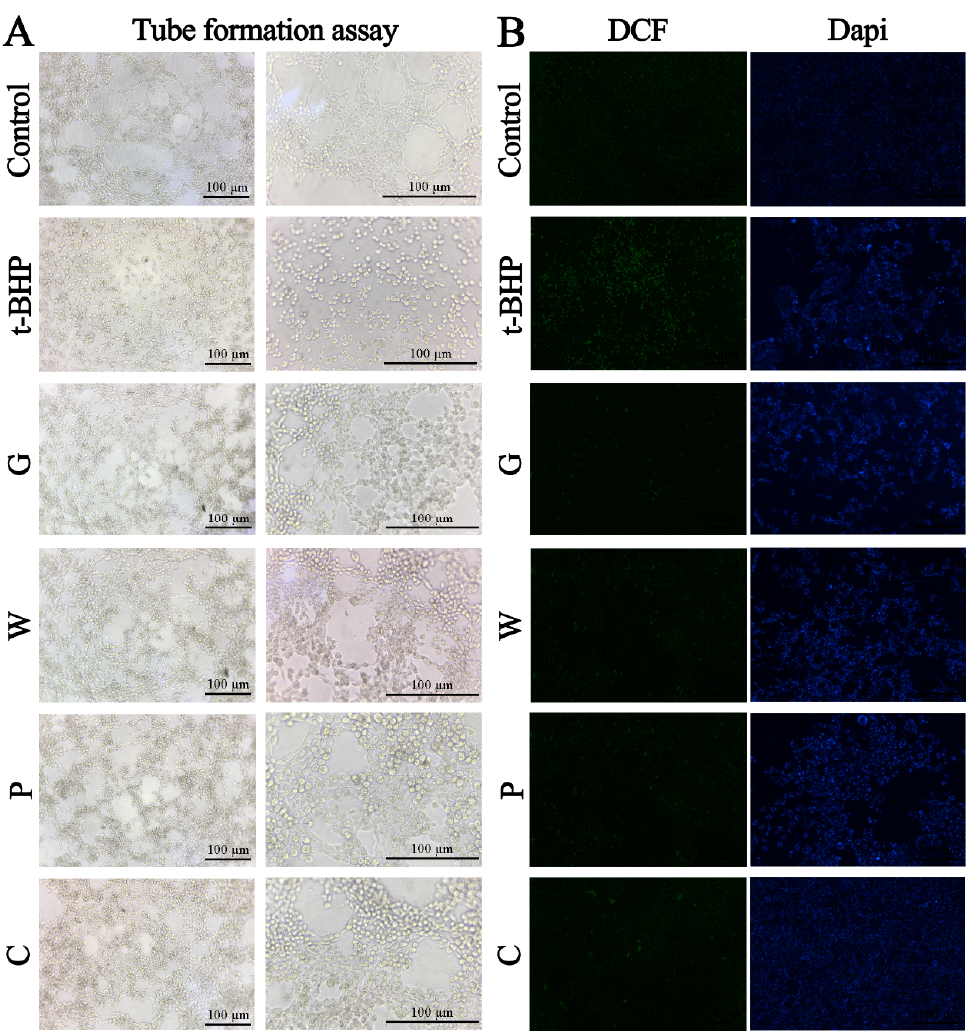
Figure 5. Efficacy evaluation of the crude and the processed Curcuma zedoaria on ROS related oxidative damage by HBMEC assays. ( A ) Angiogenesis of HBMECs under the microscope (100× and 200×). The most representative fields are shown. ( B ) Morphological observation of HBMECs induced by 40 μM t-BHP and/or the crude and the processed Curcuma zedoaria (83.33 mg/mL) by ROS and 4',6-diamidino-2-phenylindole (DAPI) assay under the fluorescence microscope (50× and 100×). The most representative fields are shown. DCF, compounds with fluorescence for the reflection of ROS levels. Dapi, morphological observation using DAPI Staining. Con, control group treated with PBS; Mod, model group treated with 40 μM t-BHP; Pos, positive control group treated with emodin (12.5 μg/mL); G, W, P, C, cells treated with Curcuma kwangsiensis S. G. Lee et C. F. Liang, Curcuma wenyujin Y. H. Chen et C.Ling, Curcuma phaeocaulis Val., and vinegar-processed Curcuma zedoaria at doses of 83.33 mg / mL, respectively. All experiments were performed three times, and the results are expressed as the mean ±